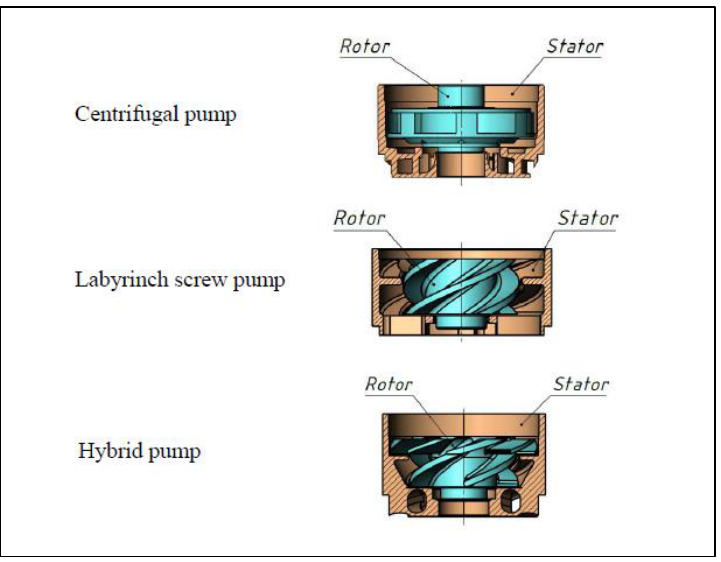
Figure 17. Dependence of pump head coefficient (K) on pump output for different pump versions. Source: authors’ development.